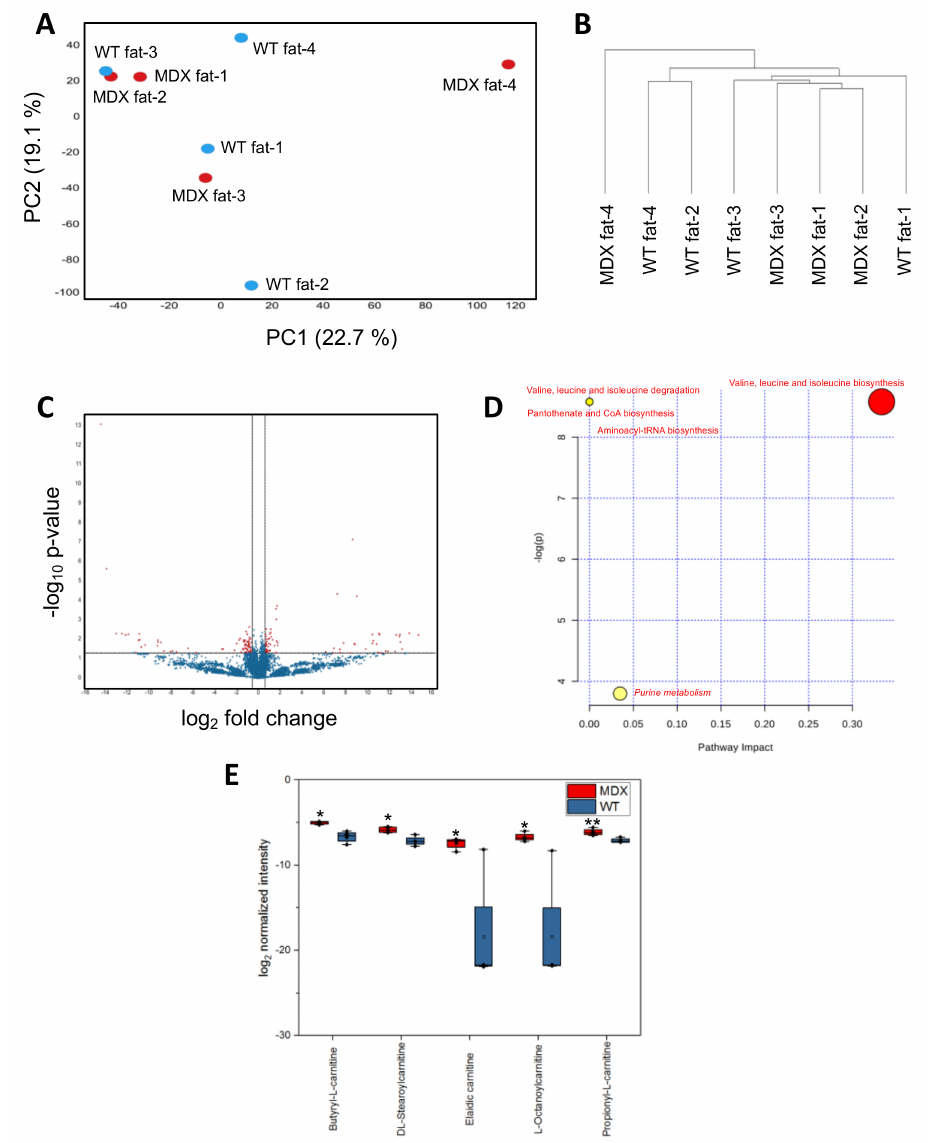
Figure 5. APC metabolomic analysis. ( A ) A principal component analysis (PCA) plot derived from nontargeted metabolite profiling of APCs isolated from four WT control and four MDX mice. ( B ) A dendrogram depicting hierarchical clustering results of samples from ( A ). Clustering method: complete linkage. Distance measurement: Euclidean. ( C ) A volcano plot depicting DAMs between WT and MDX APCs. Horizontal and vertical dashed lines represent a threshold of p -value 0.05 and fold change 1.5, respectively. One-hundred-and-fifty-three features were identified to be significant from 11,151 total features. ( D ) Pathway analysis of serum DAMs. Italics: pathways with multiple metabolites implicated. Red: metabolic pathways identified in common with both serum and muscle satellite cell analyses. ( E ) A bar graph quantifying the relative abundance of five acylcarnitine species. * p < 0.05, ** p < 0.01. n = 4 mice in each experimental